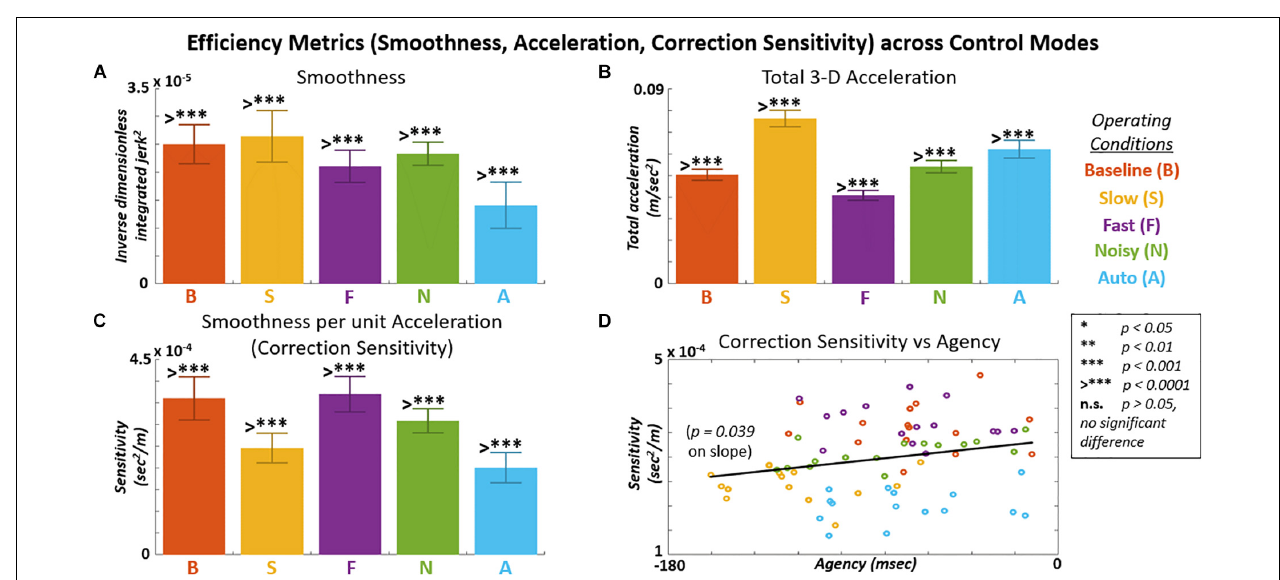
FIGURE 9 | Various metrics of movement efficiency shown across control modes. (A) Smoothness values made dimensionless and inverted so higher values indicate greater smoothness. (B) Total acceleration in 3-D indicates magnitude of corrections made in tracking constant velocity target trajectory. (C) Smoothness per acceleration (correction sensitivity) computed to indicate smoothness achieved as a function of correction effort. (D) Correction sensitivity positively related to implicit agency across subjects and control modes (F-stat = 4.40, p = 0.039).